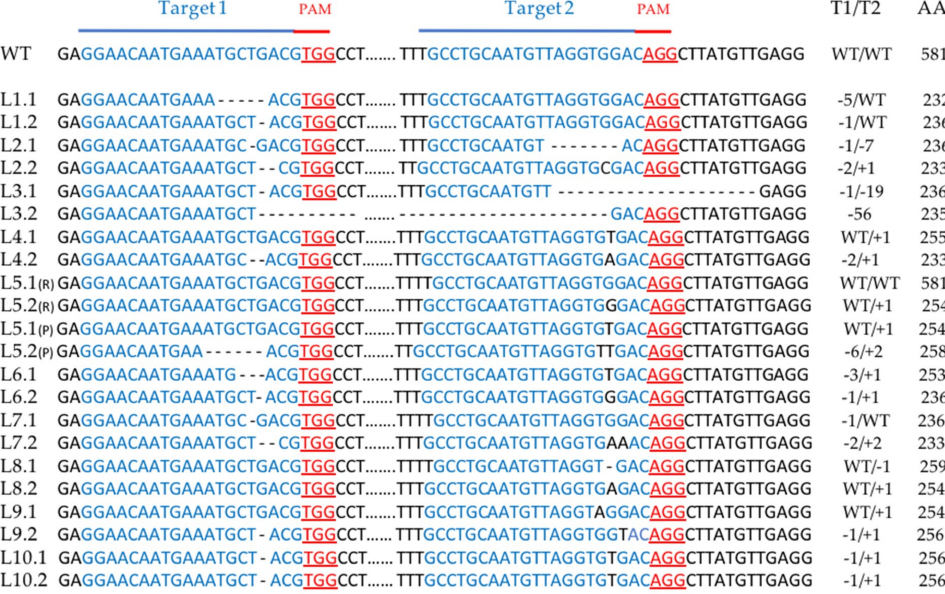
Figure 4. Sequence analysis of the two alleles of the 10 albino hairy root lines. The target sequences are depicted in blue and the PAM sequences in red. The change in the number of nucleotides is shown on the right of each allele sequence. A + indicates an insertion and a – stands for a deletion. WT indicates that there is no mutation. Example: -5/WT = deletion of 5 nucleotides on the first target site, no mutation on the second target site. For the L5: (R) = Hairy root stage sequence, (P) = plant stage sequence. The length of the amino acid chain in the truncated protein is shown on the right. Lx.x: line